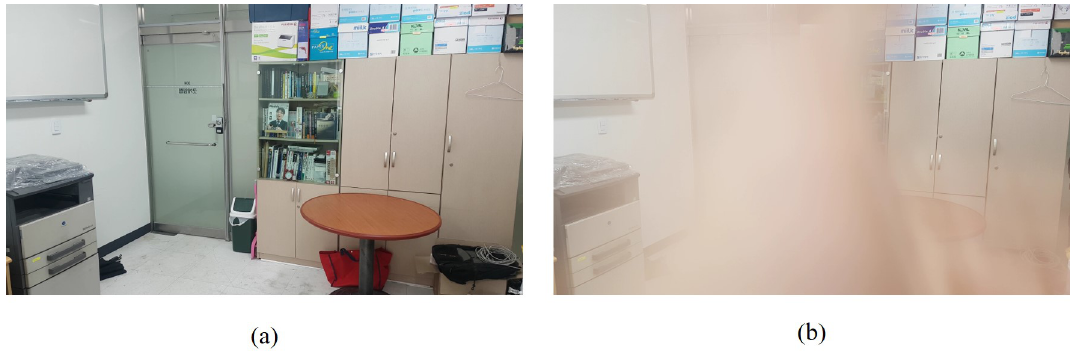
Figure 7. Experimental setup for accuracy evaluation of camera trajectory. ( a ) experimental space in normal condition; ( b ) experimental space with occlusion. Oculus was used to record the ground truth for comparing camera trajectory with HoloLens and RGB